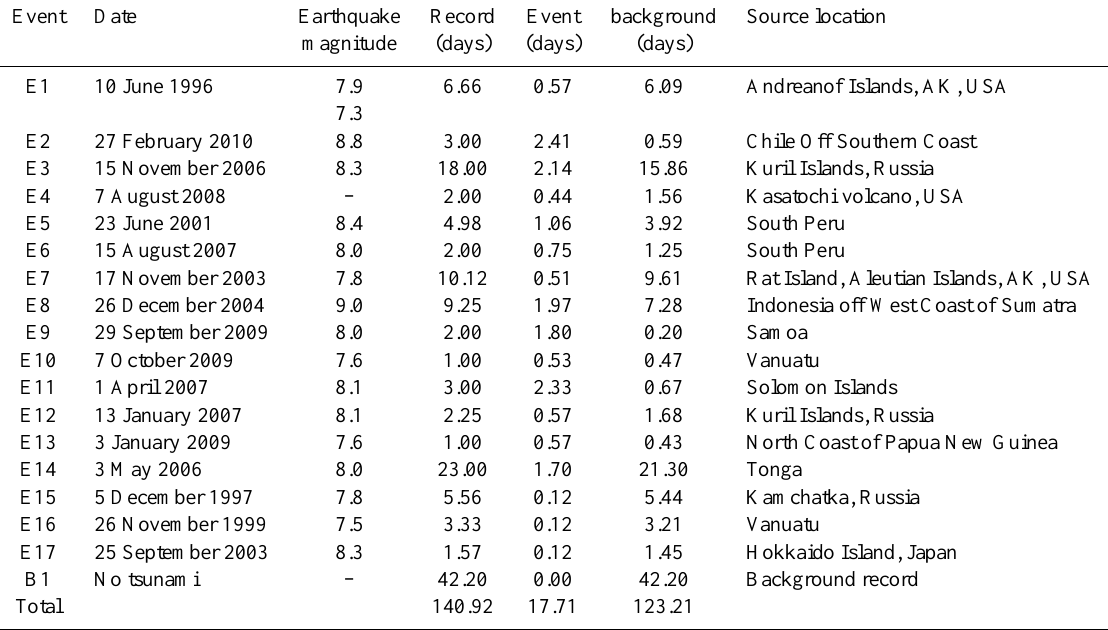
Table 2. Tsunami events. Date and location of the tsunami are listed, together with the magnitude of the tsunamigenic earthquakes. Event E4 is of volcanic origin. For each event, the total length (in days) of the examined record is given and it is further split into the length of the tsunami signal and the length of the background signal. Additional time series with no tsunami have also been examined, with length given in raw B1. Altogether the total length of the background signal analysed is about 123 days. The event E1 is indeed a double tsunami with two earthquake sources: the main shock followed 11h later by a smaller